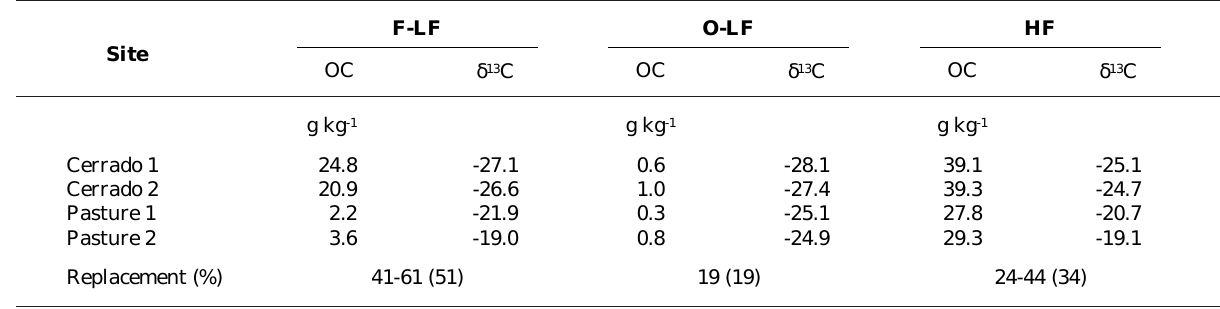
Table 2. Distribution of organic C and ddddd 13 C in the different density fractions: free light fraction (F-LF), occluded light fraction (O-LF), and heavy fraction (HF). The bottom row show the replacement of C (range and mean) from the “cerrado” vegetation (C3) by the C from pasture (C4), after 23 years of pasture